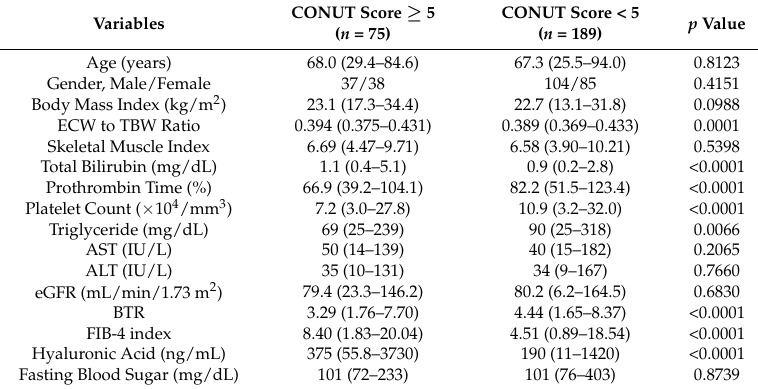
Table 6. Comparison of baseline characteristics between CONUT score ≥ 5 and CONUT score < 5.